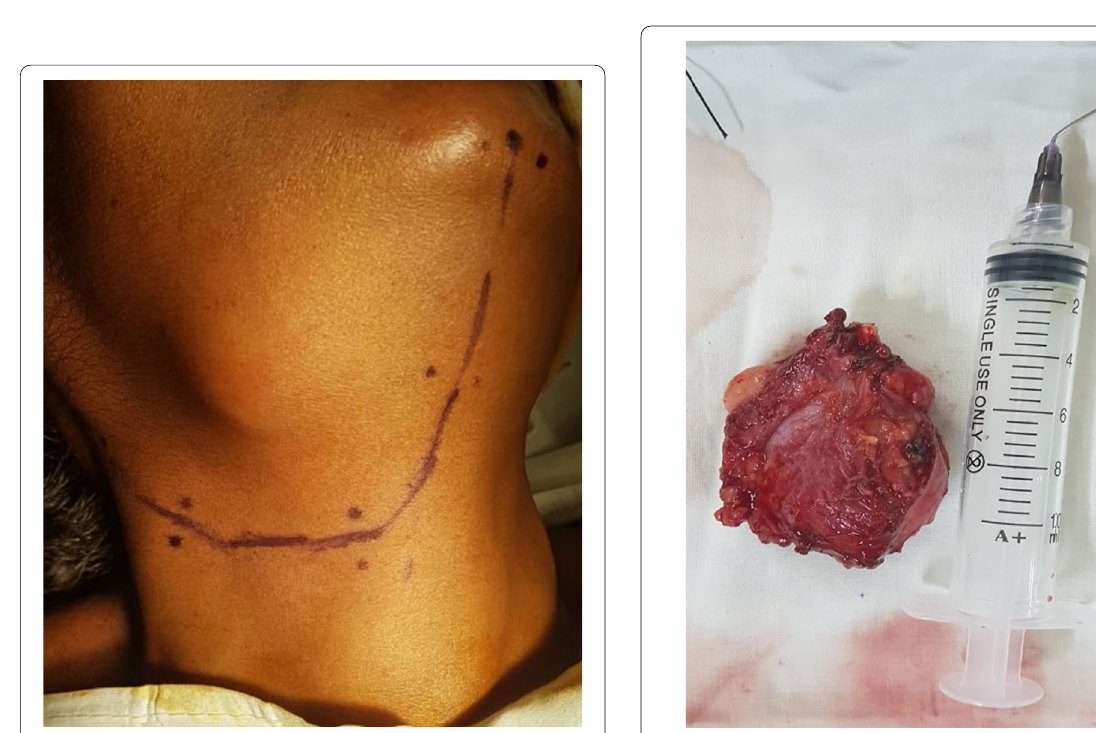
Fig. 5 Excised lesion along with submandibular